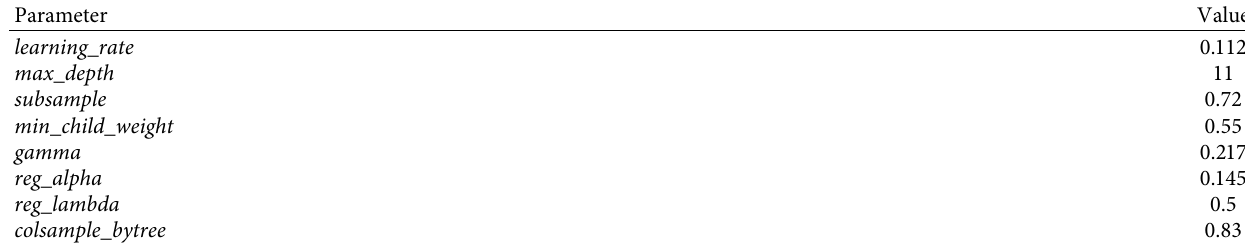
Table 1: The final superparameters of XGBoost algorithm.